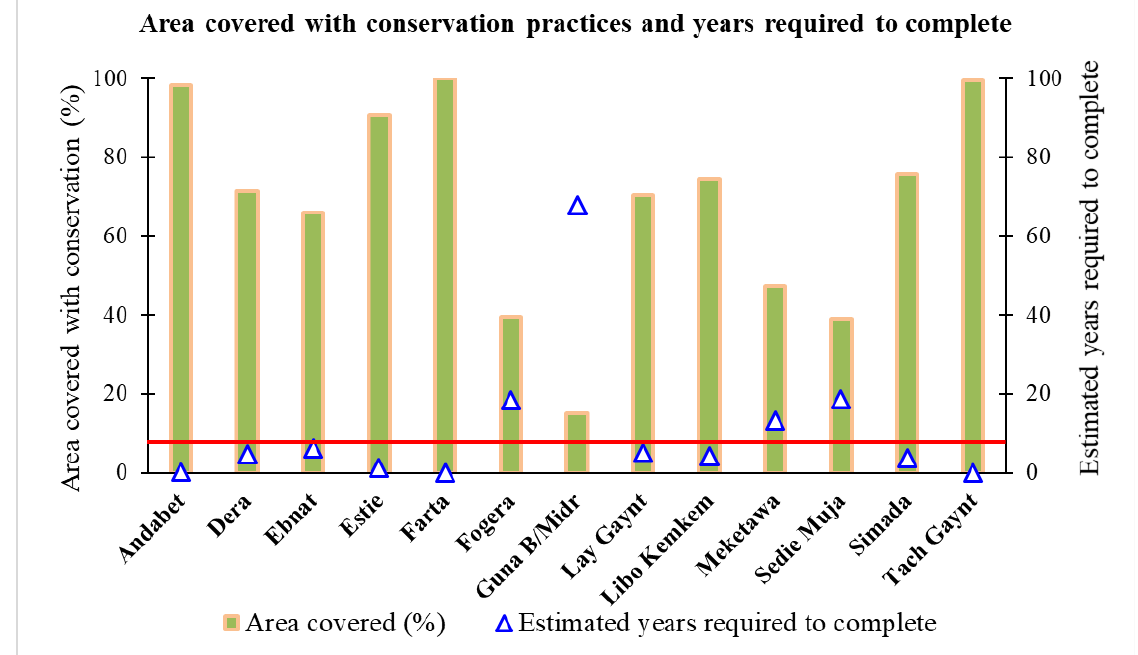
Figure 4. Area covered with biophysical conservation measures (%) at each district in the SGZ and years required to complete the remaining area. The pink color line indicates districts requiring fewer than 5 years.